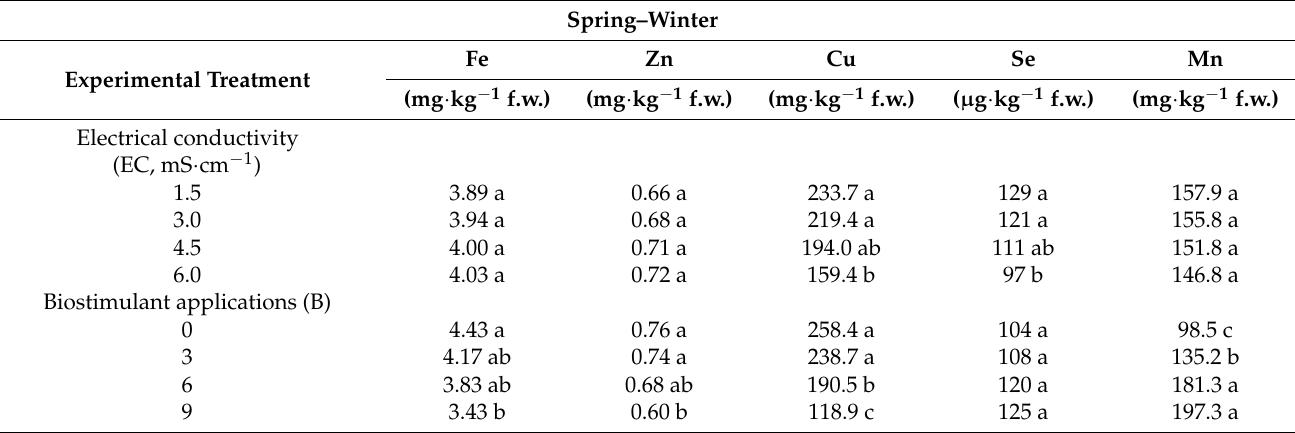
Table 6. Micro-elemental composition of tomato fruits as affected by soil EC and number of biostimu- lant